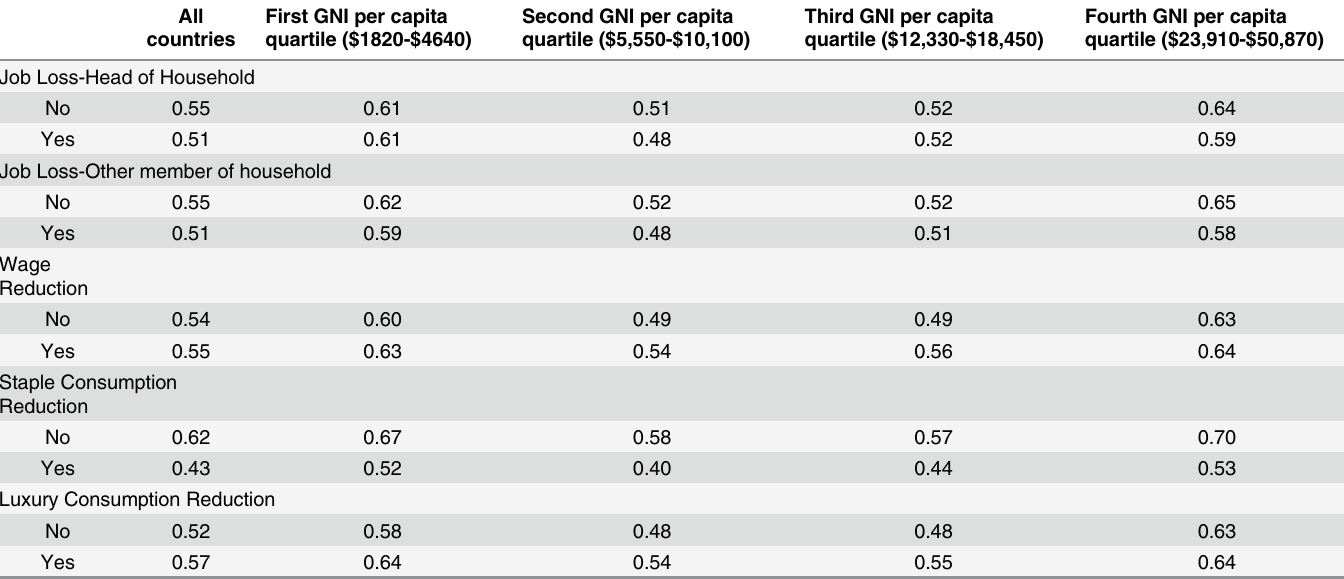
Table 11. Predicted Probability of "Good" Self-Rated Health by Specific Recession Experiences. All